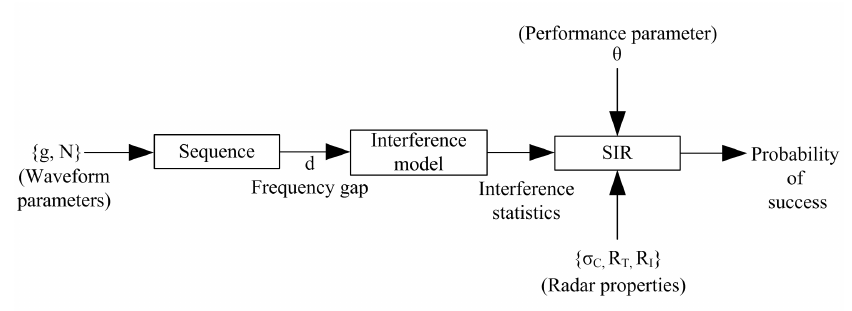
Figure 3. A block diagram of the proposed analytic framework for characterizing automotive radar